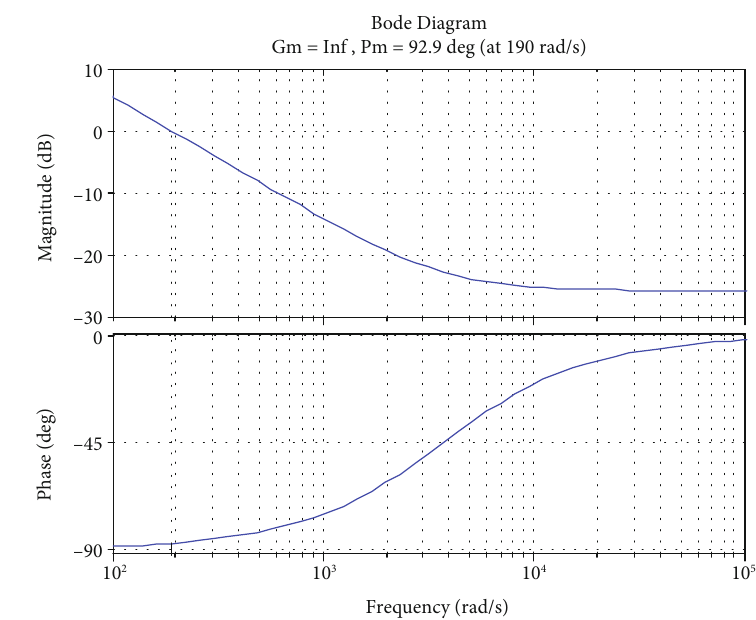
Figure 7: Frequency response of PID control.